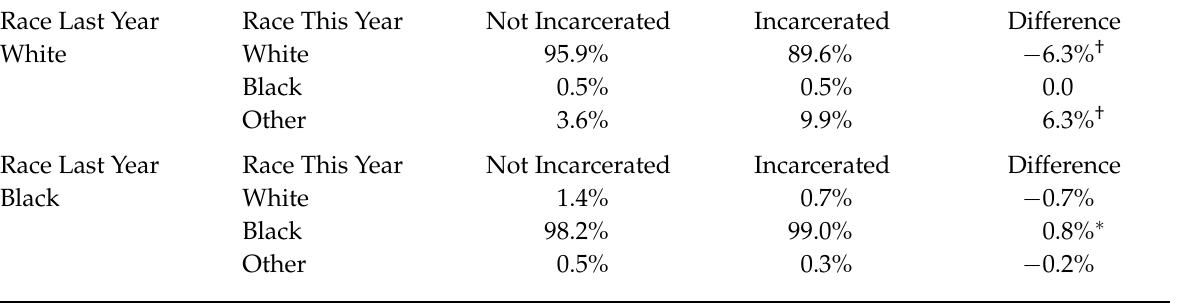
Table 1: Two sets of results purported to show a recurring pattern in the data . From Saperstein and Penner (2010) and the 1979 National Longitudinal Survey of Youth. PANEL A. Racial Classification in Previous and Current Year by Incarceration Status Race Last Year